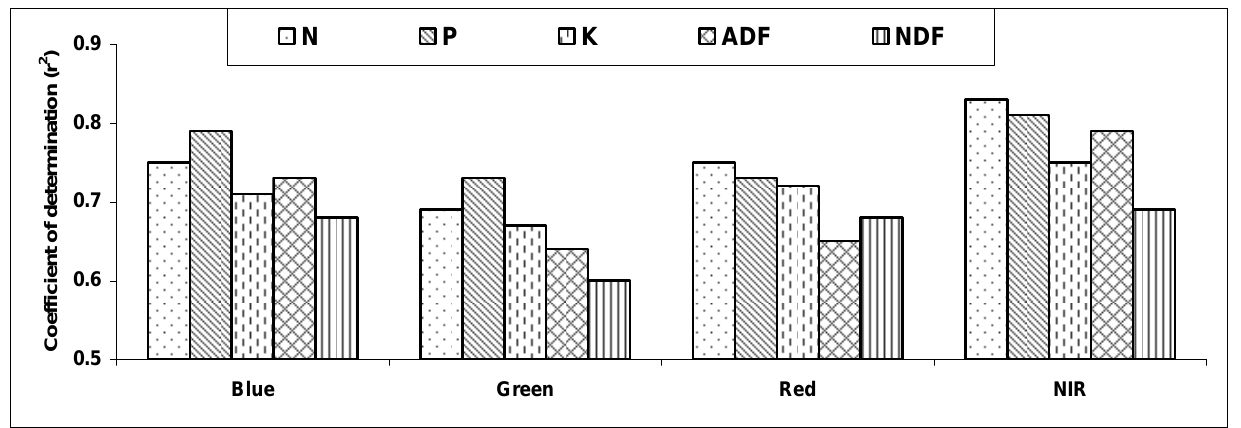
Figure 1. Coefficients of determination (r²) of forage nitrogen (N), phosphorus (P), potassium (K), acid detergent fiber (ADF) and neutral detergent fiber (NDF) with canopy reflectance in broad wavebands of blue (450-520 nm), green (520-600 nm), red (630-690 nm) and near infrared (NIR, 760-900 nm)